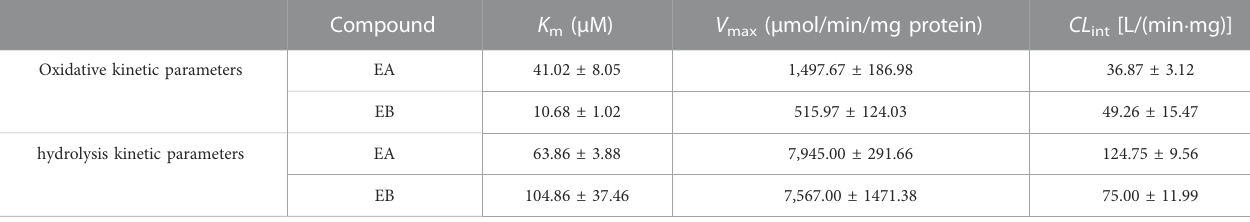
Table 2. The values of carboxylesterase-mediated CL int of EA and